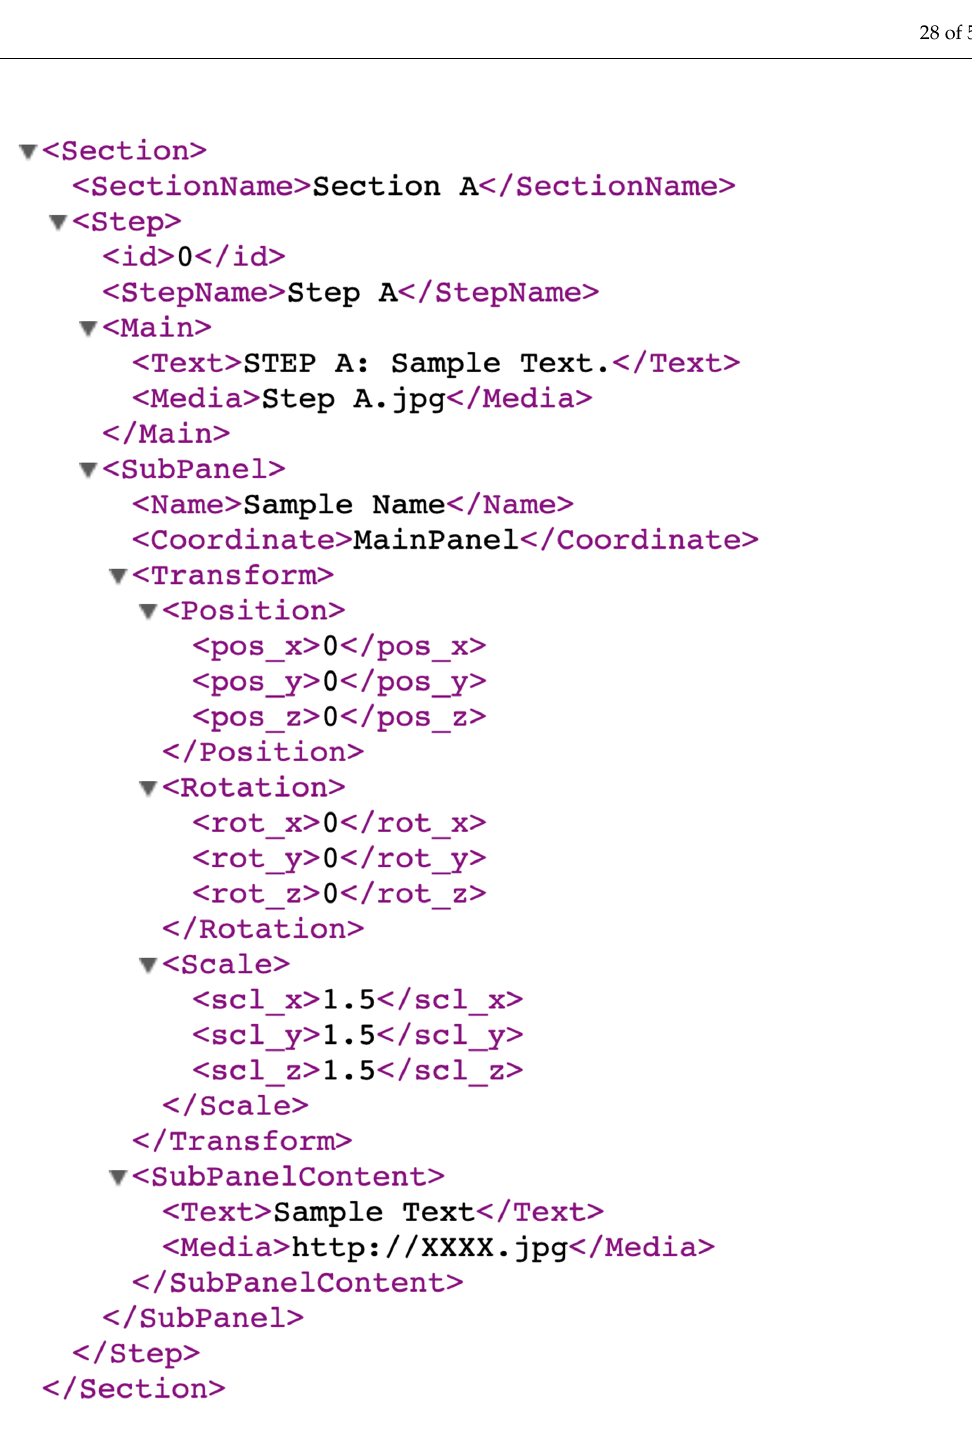
Figure 21. Description example of Section element and Step element. This step uses sub-panel as an Elaboration